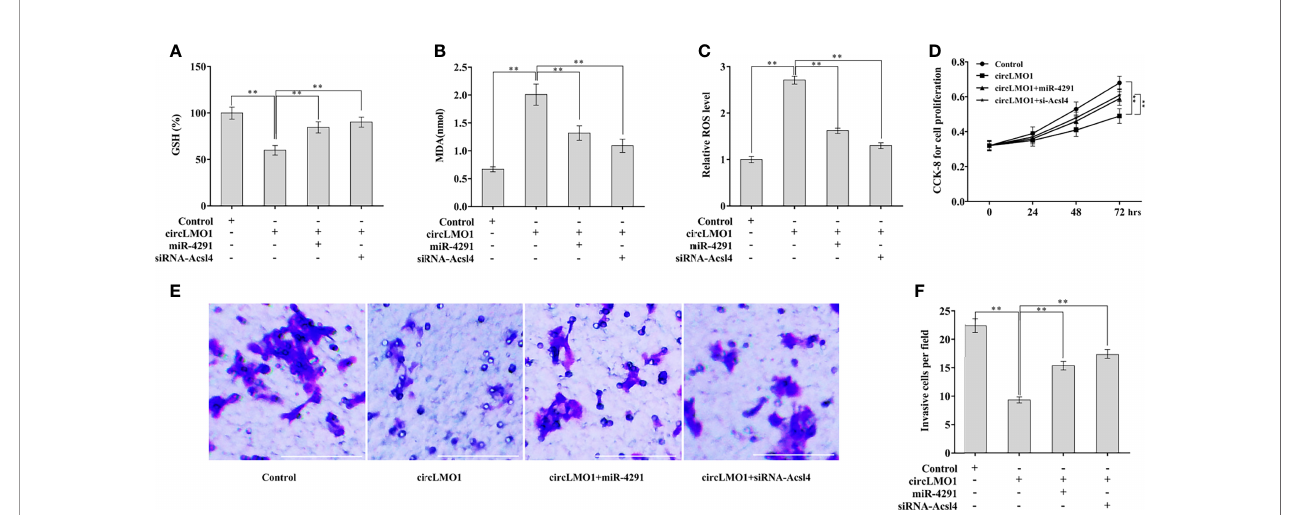
FIGURE 7 | CircLMO1 promotes cervical cell ferroptosis, and inhibited cell proliferation and invasion in a miR-4291/ACSL4-dependent manner. Relative GSH content (A) , MDA content (B) , and ROS level (C) in CaSki cells were assessed after circLMO1 overexpression in the presence or absence of miR-4291 mimics (or siRNA-Acsl4). (D) CaSki cell proliferation were assessed using CCK-8 assay after circLMO1 overexpression in the presence or absence of miR-4291 mimics (or siRNA-Acsl4). (E, F) CaSki cell invasion were assessed using transwell invasion assay after circLMO1 overexpression in the presence or absence of miR-4291 mimics (or siRNA-Acsl4). **p <